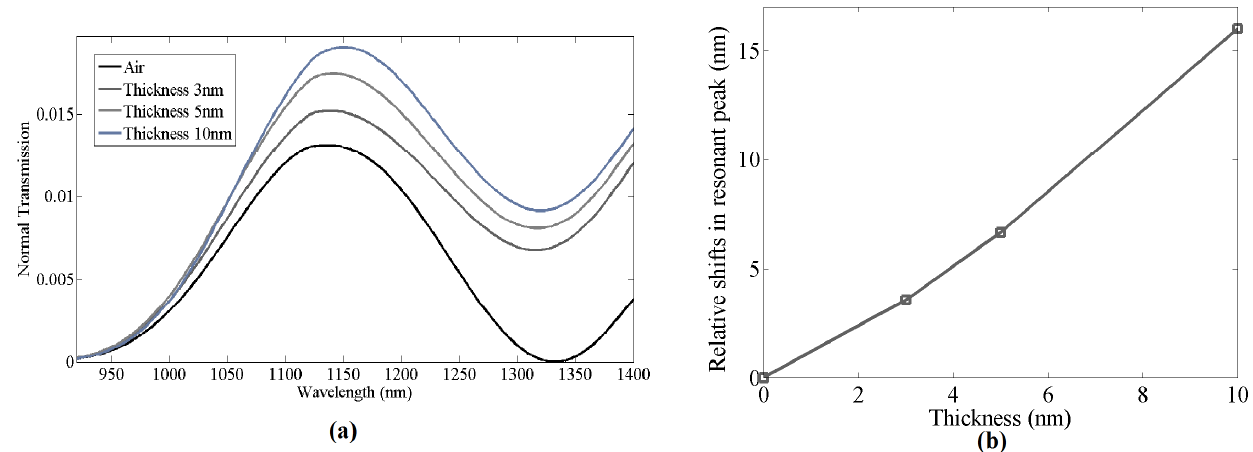
Figure 2. Simulation results: (a) Shifts in resonant peak due to bio-material coatings of different thickness on silicon gratings; (b) Shifts in resonant peak wavelengths with respect to thickness of